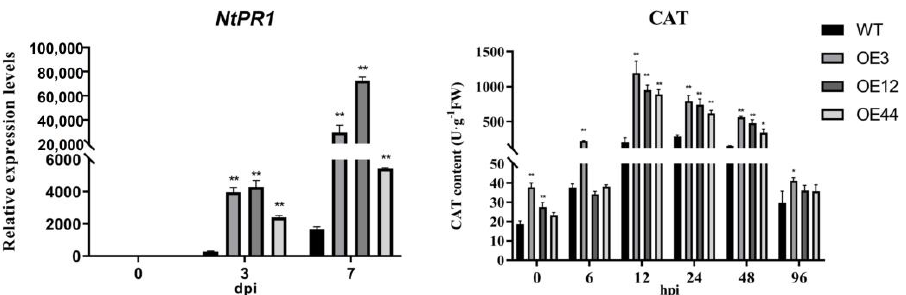
race 0. Asterisks denote significant differences (compared with the control group): * p < 0.05, ** p < 0.01, by Student’s t -test. ** p < 0.01, by Student’s t